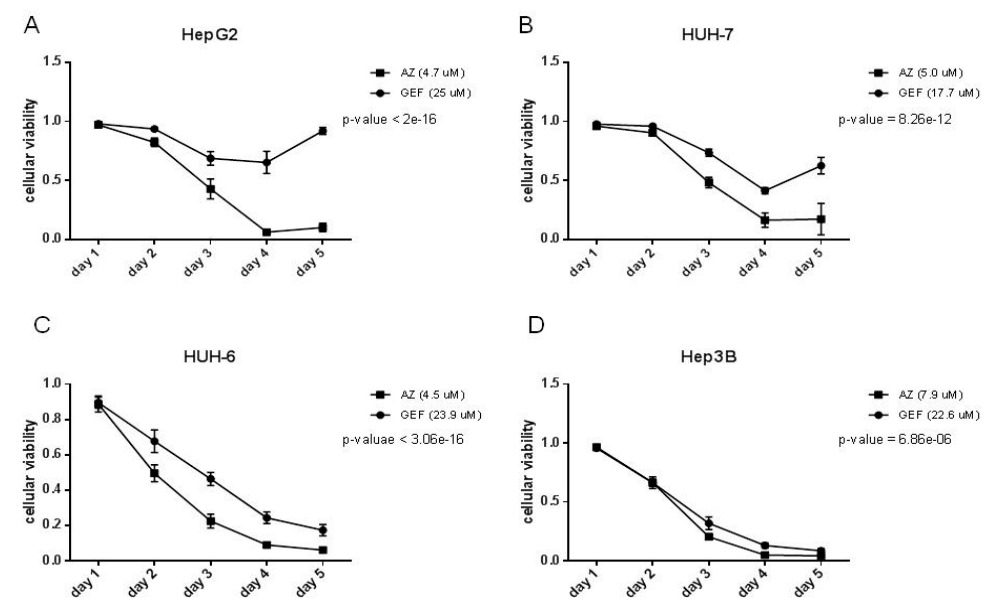
Figure 4. Five days proliferation assay of ( A ) HepG2, ( B ) HUH-7, ( C ) HUH-6, and ( D ) Hep3B cell lines. 10% FBS culture medium was added with GEF IC50 or AZ IC50 (as indicated in Table 1), DMSO as control. Data are plotted in the graph as normalized by DMSO.